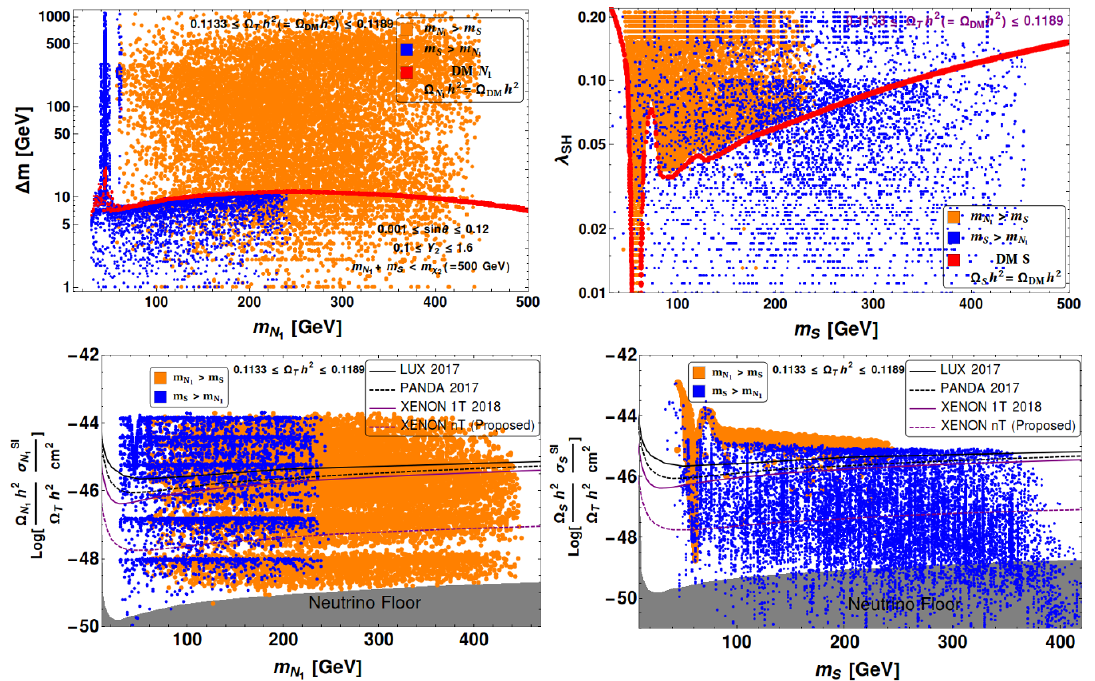
Figure 11 . [Top Panel] Relic density allowed parameter space for two component DM model in m N (cid:1) m (top left) and m S (cid:21) SH (top right) planes. Two mass hierarchies: m N 1 (cid:0) (cid:0) (orange points) and m S > m N (blue points) are shown in both plots. Red points depict the case 1 of single component DM scenarios, for N 1 on the left and for S on the right panel. [Bottom Panel] Relic density allowed points are shown in DM mass vs e(cid:11)ective SI DM-nucleon cross-section planes; (cid:16) (cid:10) (cid:17) (cid:16) (cid:17) 2 (cid:10) S h 2 N 1 h (cid:27) SI m N in bottom left and (cid:27) SI m S in bottom right. Limits from di(cid:11)erent N 1 (cid:0) S (cid:0) (cid:10) T h 2 (cid:10) T h 2 1 DD experiments, LUX [9](black solid line), recent PANDA [12] (black dashed), XENON 1T [10] (purple solid line) and predicted XENON nT [11] (purple dotted line) are also indicated in the (cid:12)gures. Shadded region correspond to Neutrino (cid:13)oor where DM signal cannot be distinguish from neutrino